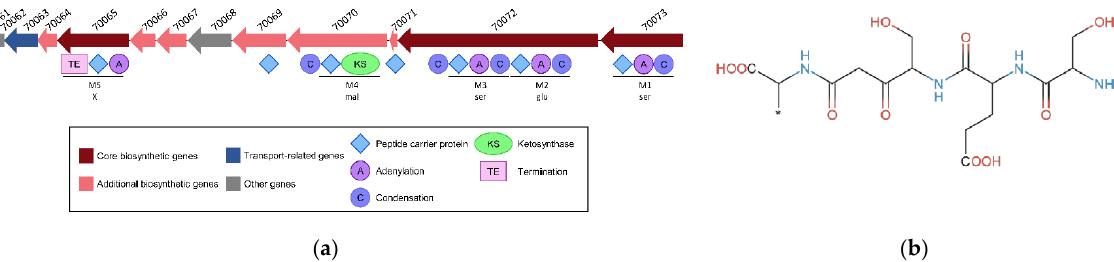
Figure 8. NRPS-PKS BGC was predicted in the genome of the strain C. maltaromaticum 10040100629. ( a ) Representation of the genetic organization where the CDSs are represented by arrows. The domains predicted in the encoded proteins are represented below the CDSs. The locus tag is indicated above the CDSs, the prefix “CMALT430_v1_” of the locus tag was omitted; ( b ) core structure of the predicted metabolite.